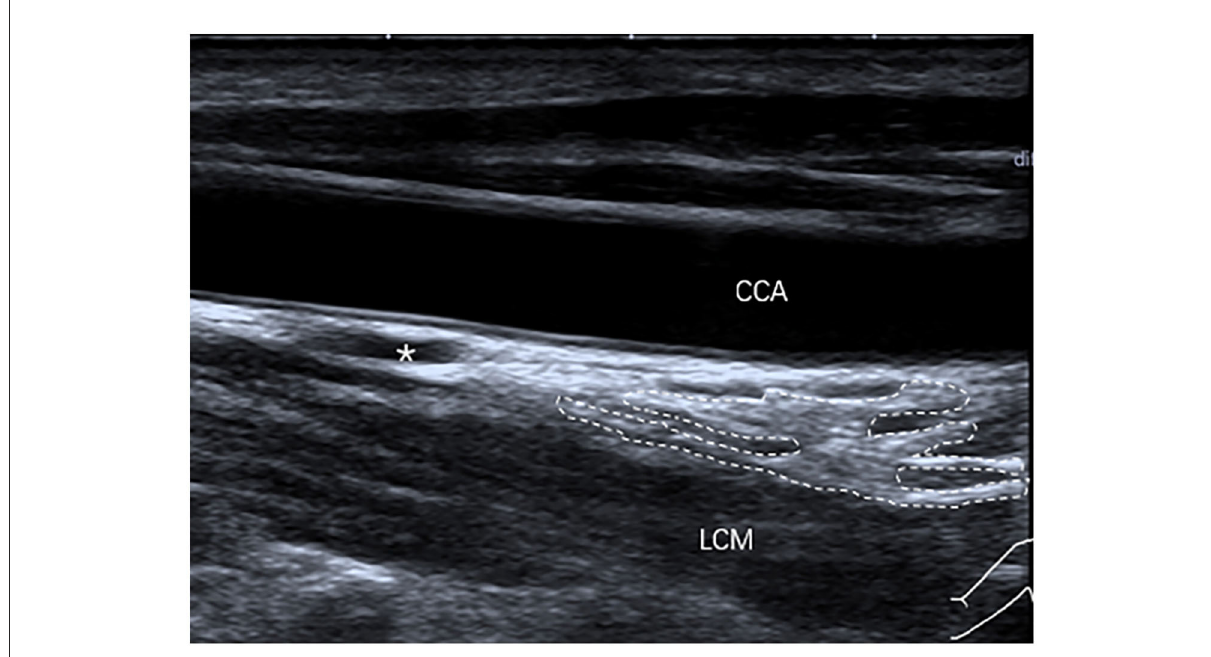
FIGURE6 The SG, with a spindle shape (outlined) and hyperechogenicity, was located between the common carotid artery (CCA) and the longus colli muscle (LCM) and was under the inferior thyroid artery (*) on the longitudinal ultrasound